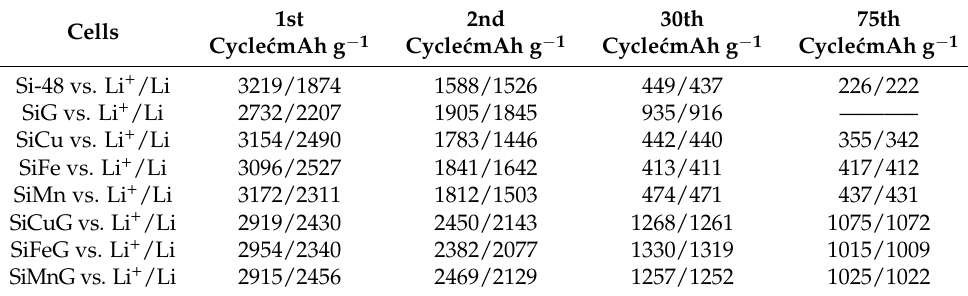
Table 1. Summarized specific capacities of all prepared anode materials at different cycles.